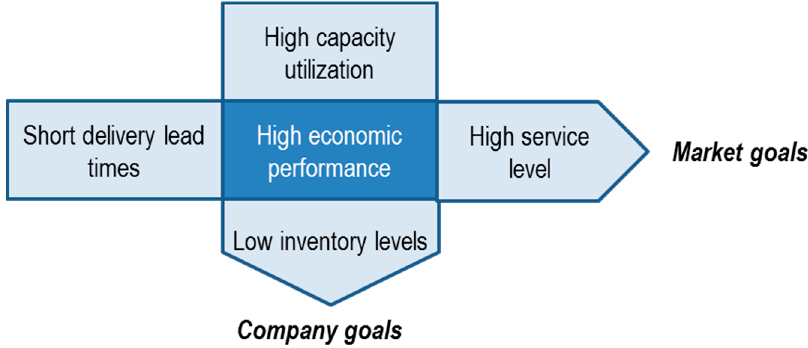
Figure 1. Multi-dilemma of production planning [32] (p. 36).